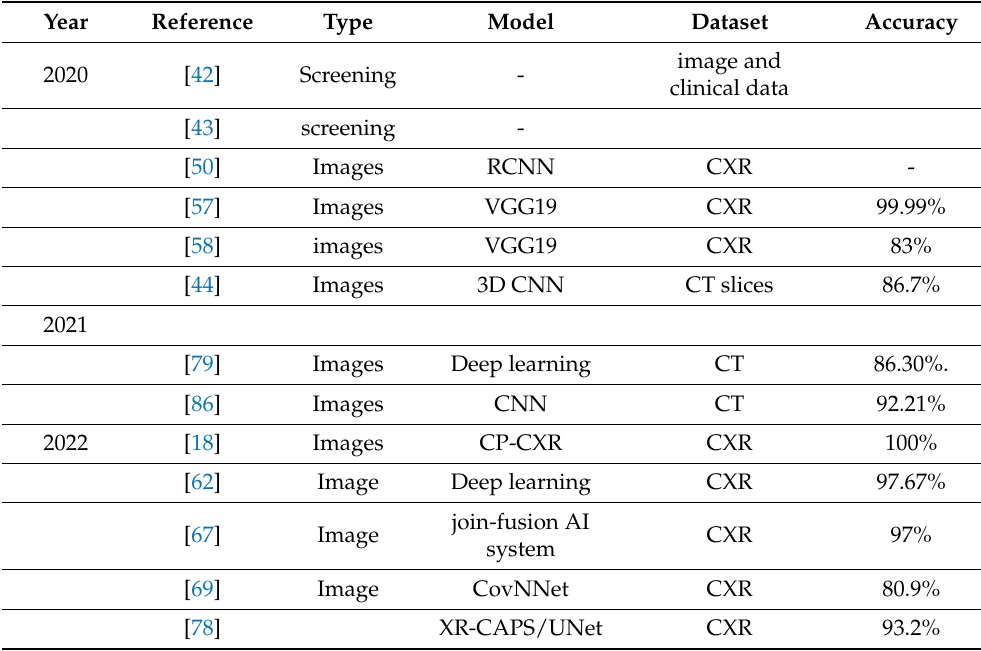
Table 1. Summary of some reviewed papers showing dataset, AI model, and study